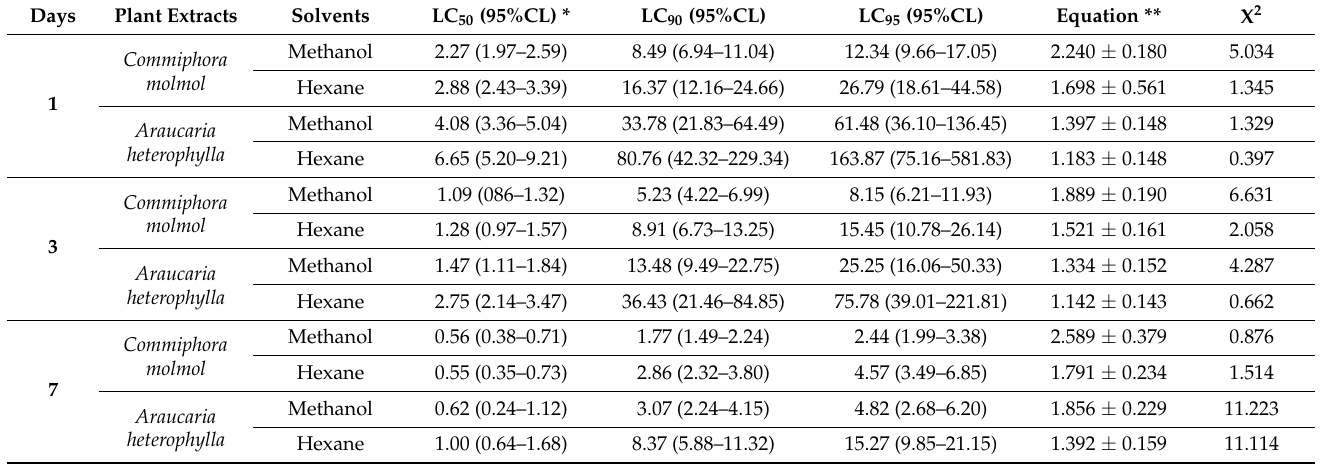
Table 6. Lethal concentration values of plant extracts of Commiphora molmol and Araucaria heterophylla against Haematopinus eurysternus